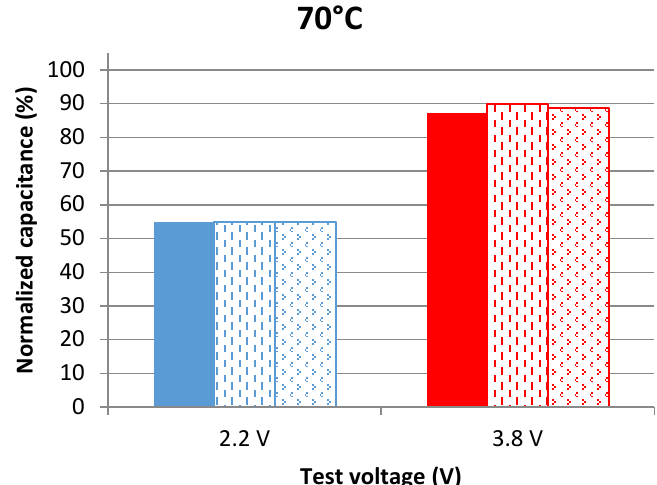
Figure 2. Capacitance evolution of cells aging at 2.2 V and 3.8 V at 70 °C after 109 days of calendar aging. The results are found from measurements in the frequency domain at 25 °C.